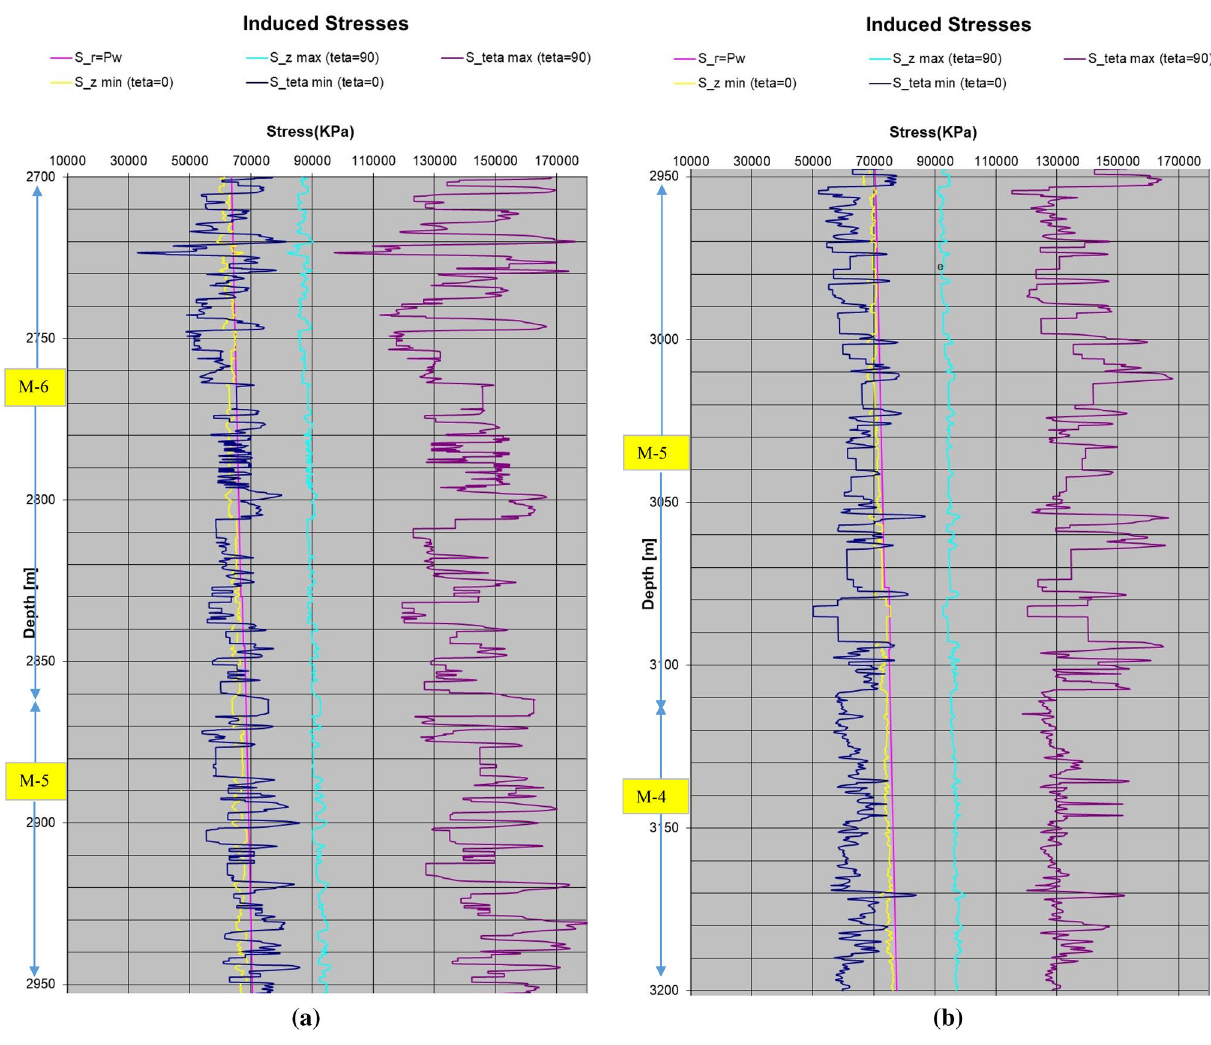
Fig. 12 a Induced stresses at the wellbore wall (in the direction of 𝜎 h ) in Gachsaran formation of well Z26 (2700–2950 m). b Induced stresses at the wellbore wall in Gachsaran formation of well Z26 (2950–3200 m) Table 13 The order of induced wellbore stresses in Gachsaran forma- tion of well Z26 (in the directions of horizontal Table 12 The ranges of induced stresses at the wellbore wall in the = 90 direction of minimum horizontal stress ( 𝜃 ) and in the direction = 0 of maximum horizontal stress ( 𝜃 ) for Gachsaran formation of Kupal field, using the MEM results of well Z26 Min